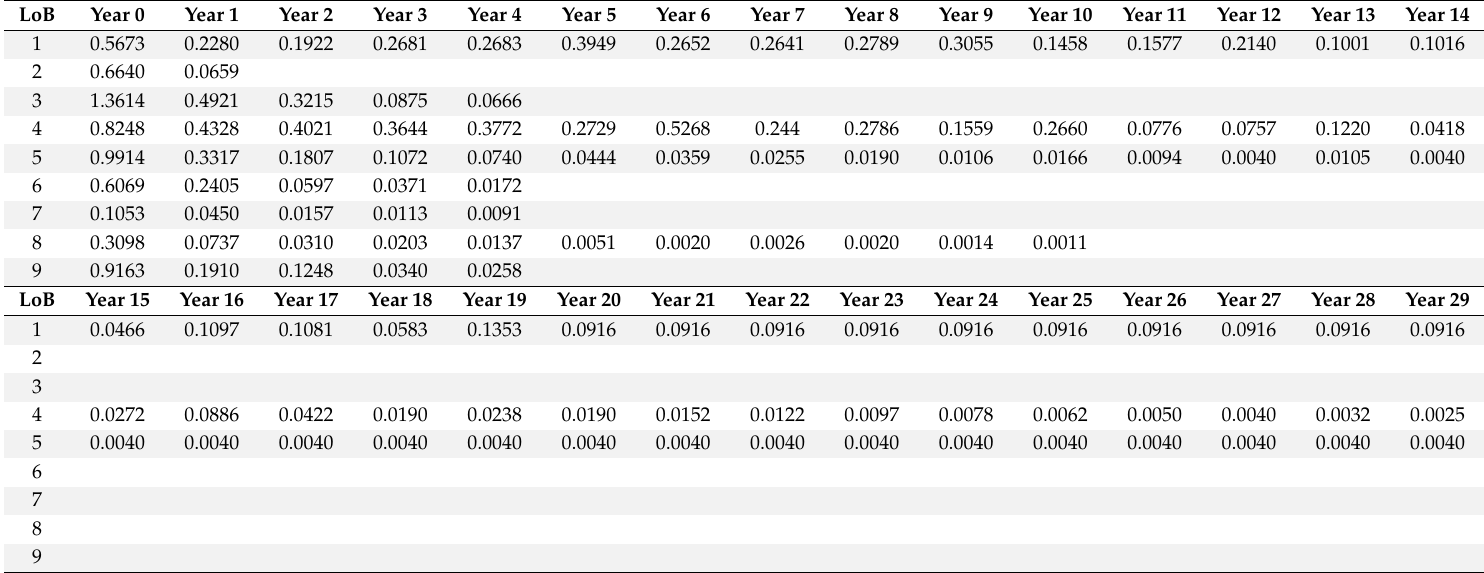
Table 4. Mack’s standard deviation parameter estimates, s j , based on exogenous triangles and for the development lengths given in Table